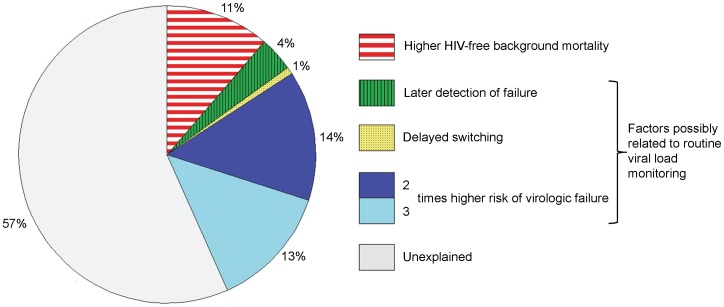
Possible explanations for the difference in mortality at three years of antiretroviral therapy between South Africa and Malawi and Zambia.The graph shows the proportion that different causes may contribute to the higher mortality observed in Malawi and Zambia (CD4 cell count monitoring) compared to South Africa (VL monitoring). The estimates are based on the mathematical model. The effect of a higher risk of virologic failure in sites with CD4 count monitoring is shown for a 2-times higher risk (dark blue) and 3-times higher risk (light and dark blue combined).